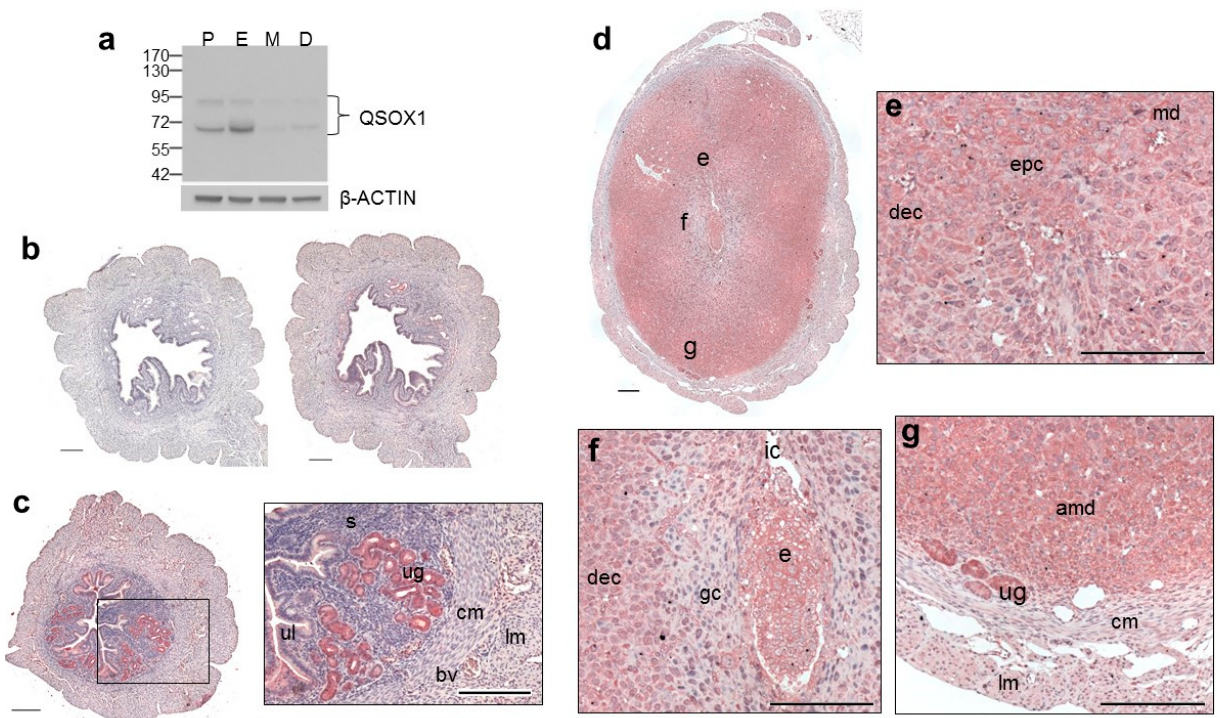
Figure 1. Expression of QSOX1 in the mouse uterus. ( a ) Western blotting detected two forms of QSOX1 in the uterus homogenates, with the ~65 kDa protein as the primary form. P, proestrus; E, estrus; M, metestrus; D, diestrus. Original blots are provided in the Supplementary Materials, Figure S1. Immunohistochemical staining of QSOX1 in the mouse uterus at non-pregnancy ( b ) or gestational days 0.5 dpc ( c ) and 6.5 dpc ( d ). The control section without treating with anti-QSOX1 antiserum showed nearly no staining signal ( b ). ( e – g ) show partial enlarged images of the uterus at 6.5 dpc ( d ). Red colors show QSOX1 staining, and blue shows the counterstain of hematoxylin in the nucleus. Scale bar = 200 μ m. Abbreviations: amd, anti-mesometrial decidua; bv, blood vessel; cm, circular muscle; dec, decidua; e, embryo; epc, ectoplacental cone; gc, giant cells; ic, implantation crypt; lm, longitudinal muscle; md, mesometrial decidua; s, stroma; ug, uterine glands; ul, uterine lumen.